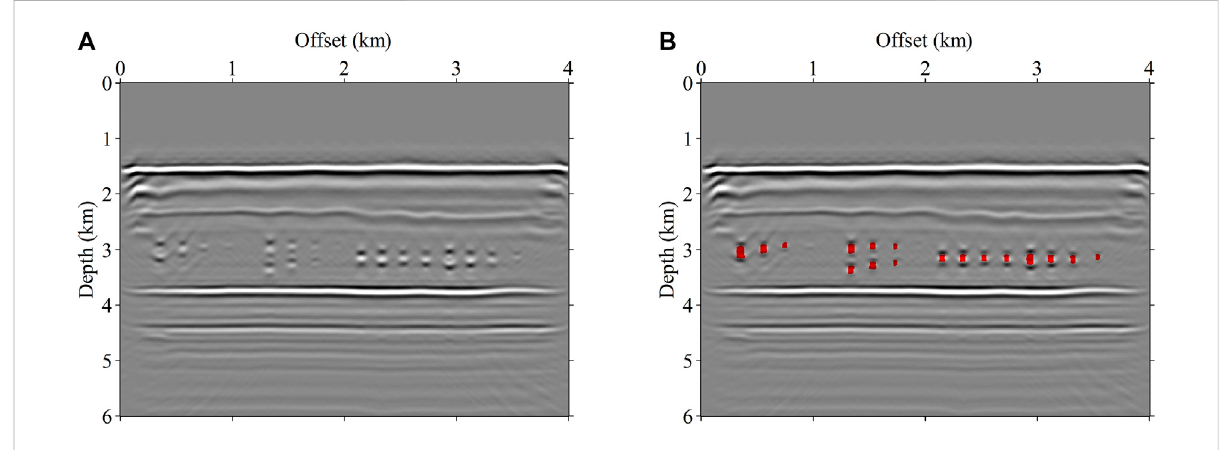
FIGURE 12 Theimagingresultsandpredictionresultsofthephysicalsimulated dataonthecrosslinesection. (A) istheseismicimage,and (B) istheoverlaid display of (A) and the predicted